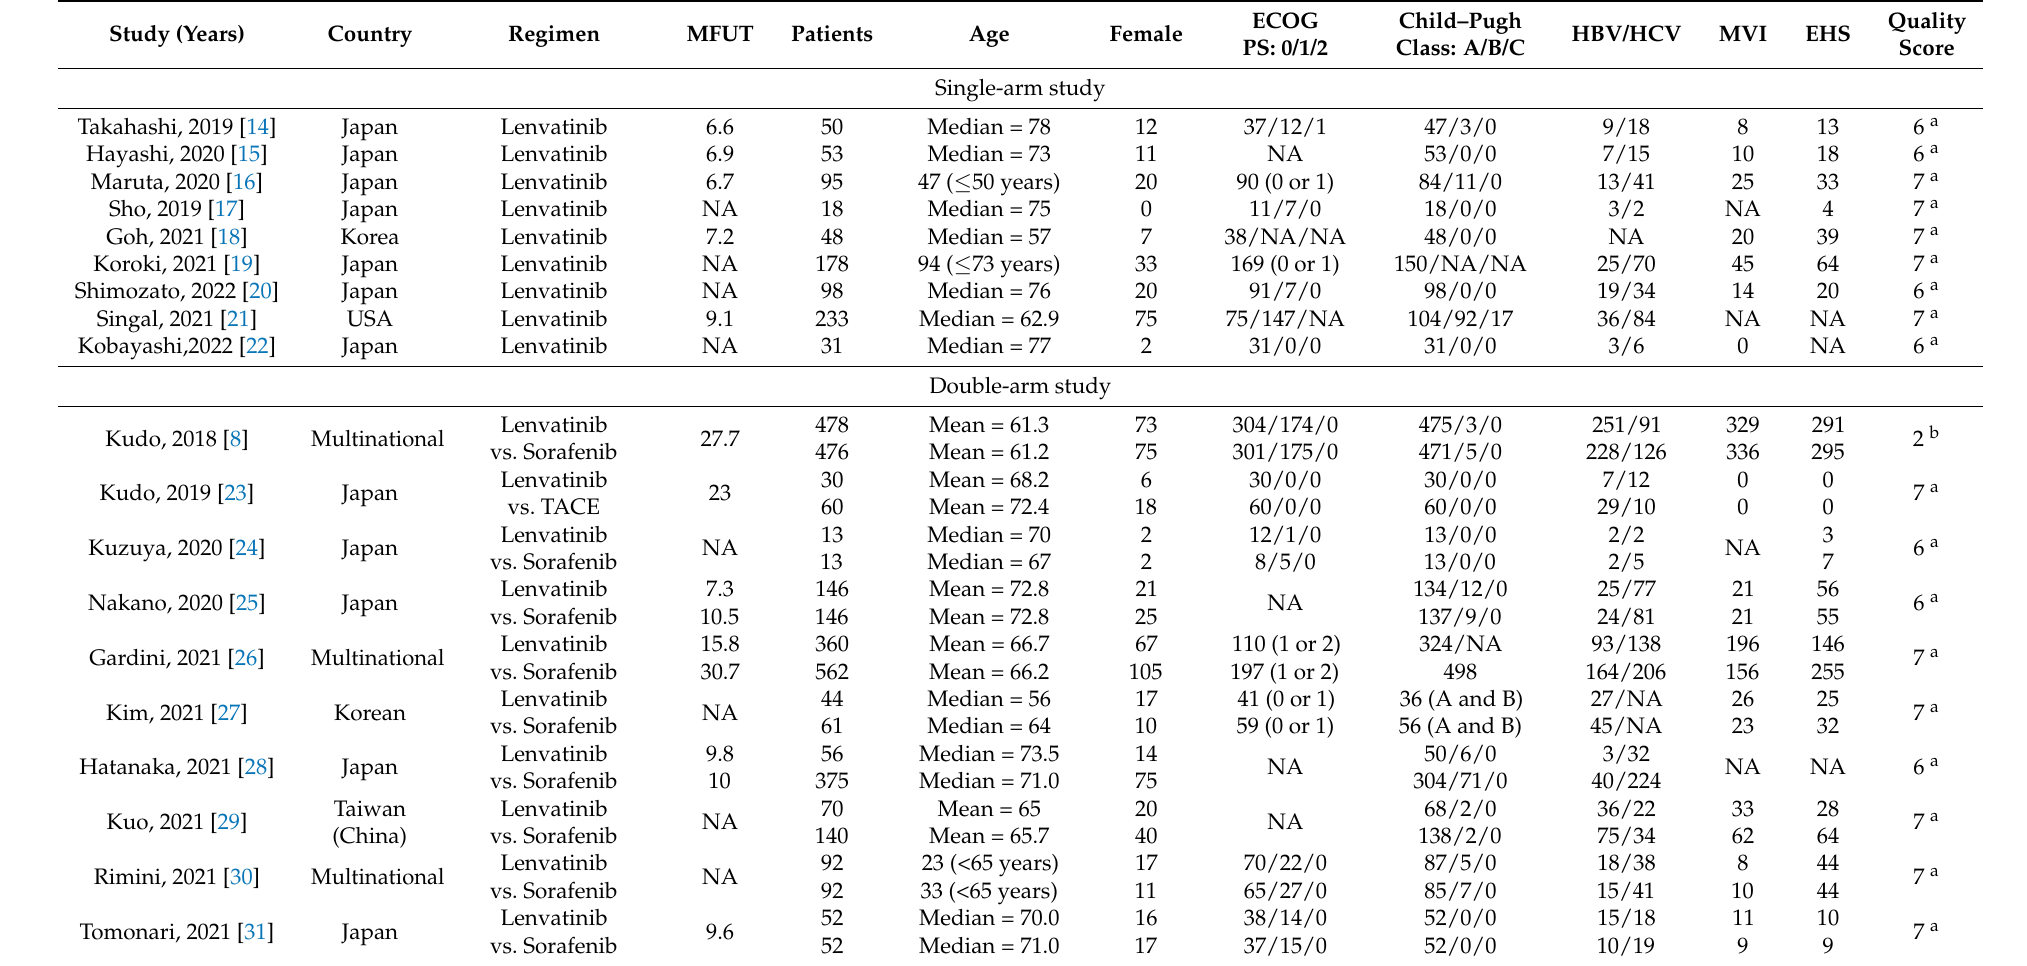
Table 1. Baseline characteristics of patients recruited in the included